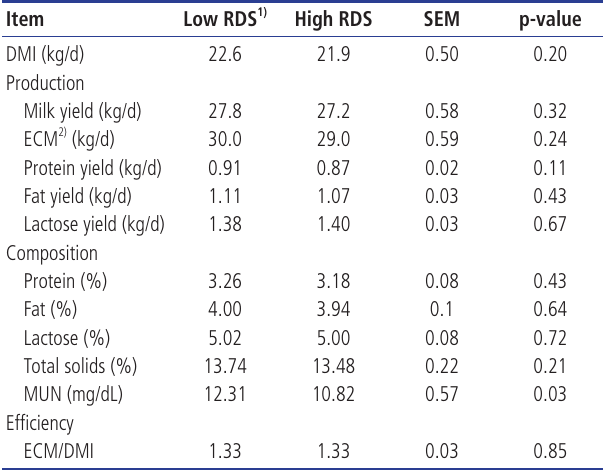
Table 3. Effects of dietary ruminally degradable starch levels on dry matter intake and lactation performance of dairy cows Item